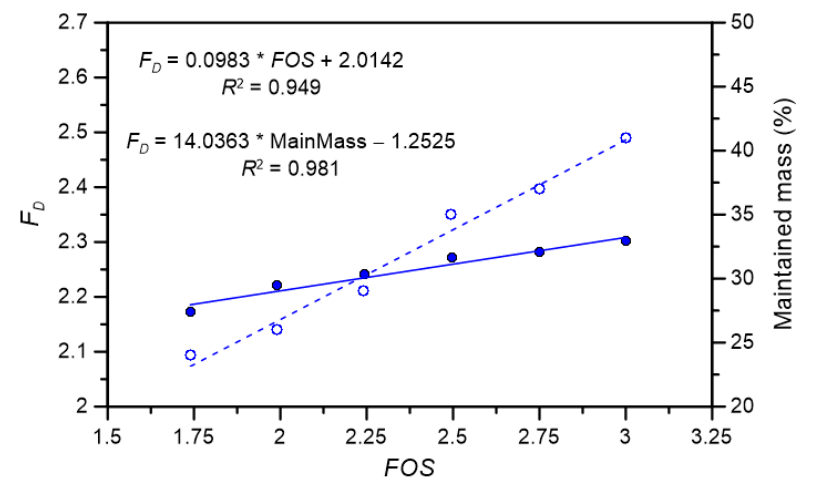
Figure 13. FOS vs. fractal dimension for experiment OT3.